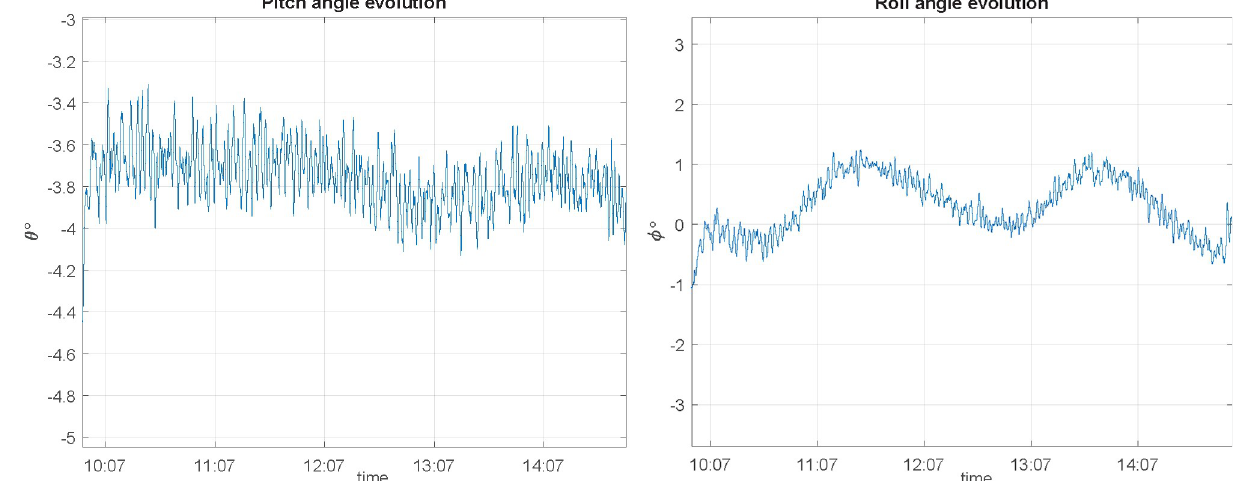
Fig 19. Pitch and roll angle evolution for a trajectory guided circle path, at v = 1 m/s, e vel = 0.2 m/s and R = 50 m.